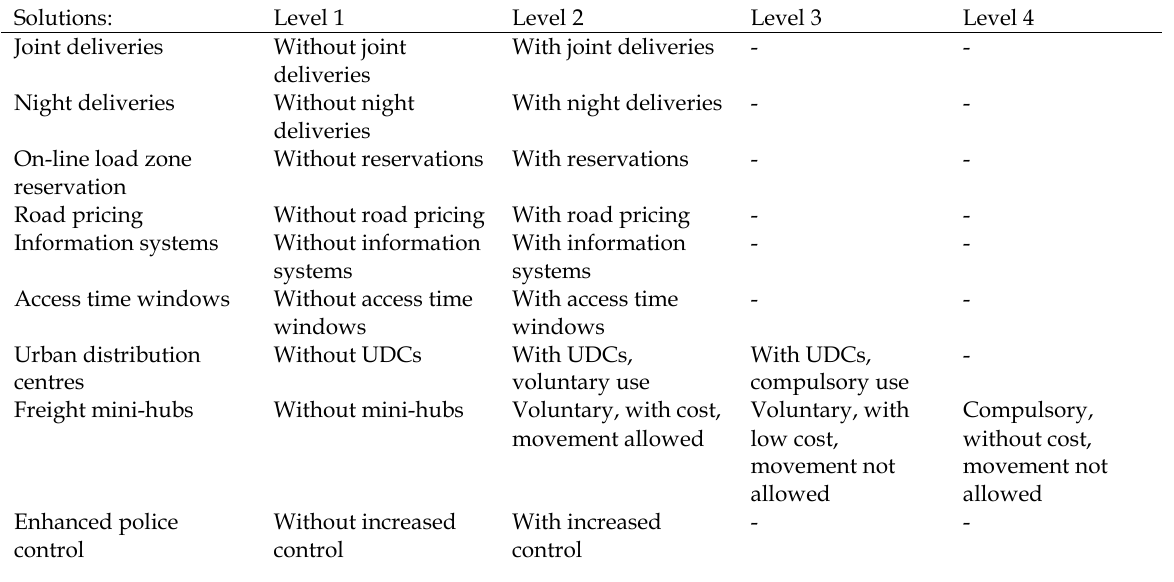
Table 1. Solutions proposed and different levels of each